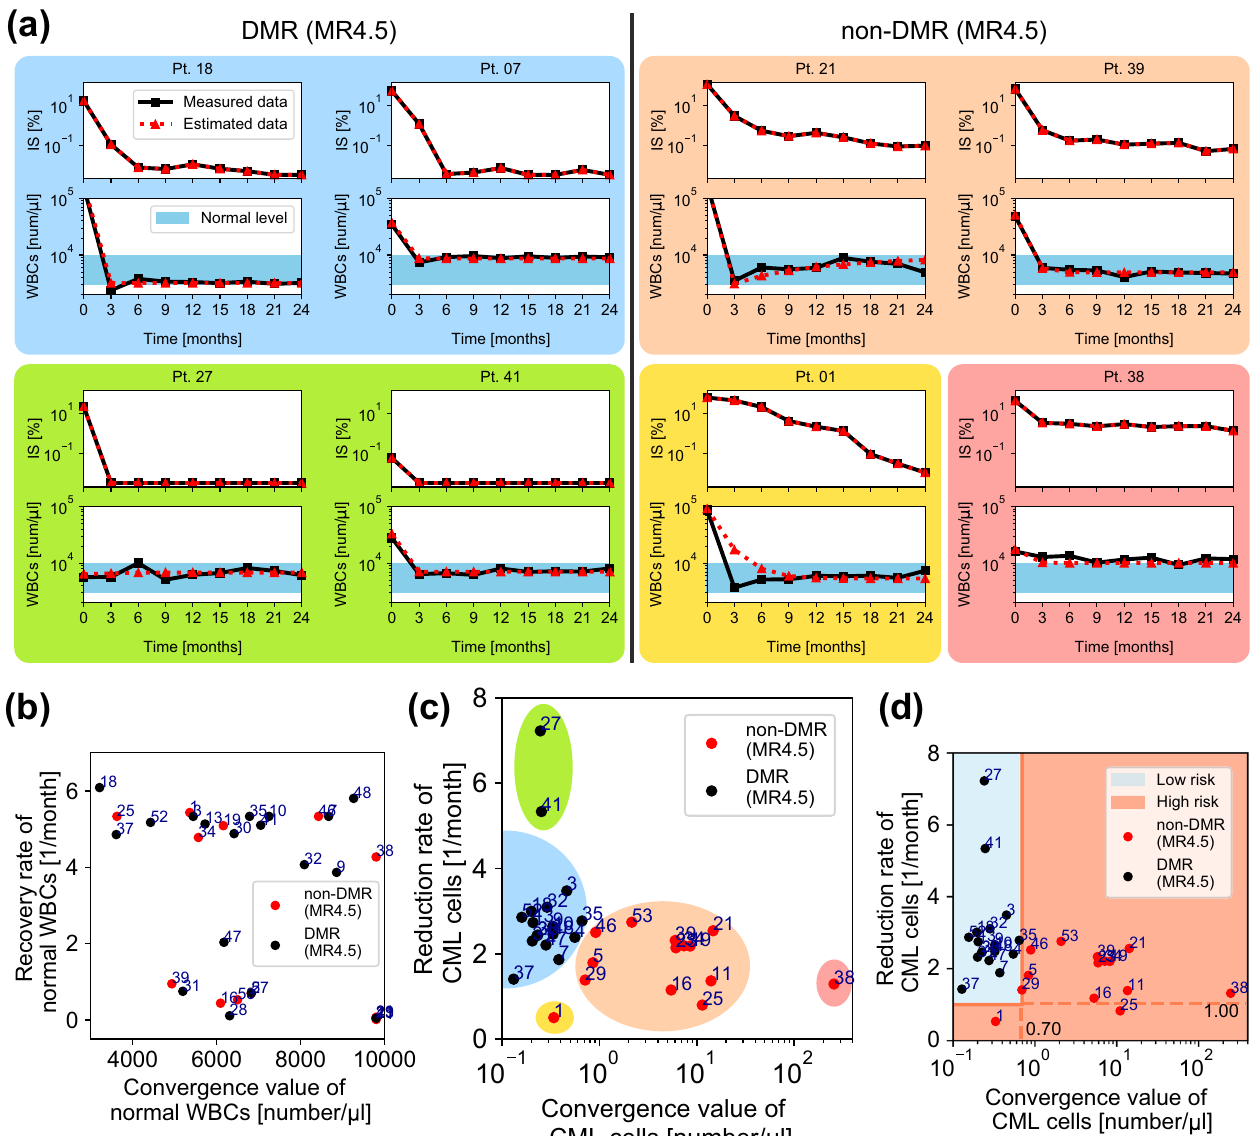
Fig. 3 DMR and non-DMR patients were separated on the plane of the reduction rate and convergence value of CML cells. a The estimated time series of CML dynamics (red dashed lines) suf fi ciently approximated the measured data for IS [%] and for WBC counts [number / μ l] (black solid lines). The patients shown in the colored boxes were chosen as examples from the patients within the same color regions shown in ( c ). b The distribution of the convergence value and recovery rate [1/month] of normal WBCs did not show a correlation in terms of nilotinib response. The number indicated on each dot is patient #. c The distribution of the convergence value and reduction rate of CML cells was apparently classi fi ed into several subsets: a set including most DMR patients (the blue region), non-DMR patients (the orange region), and outlier patients (other color regions). d By choosing optimal threshold values, the distribution of DMR patients shown in ( c ) was perfectly separated from that of non-DMR patients. Notably, this result was obtained by using all patient data